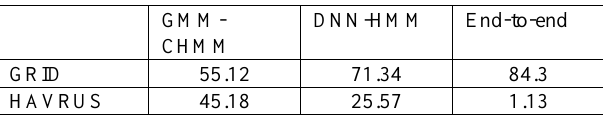
Table 1. Word Recognition Rate (WRR, %) comparison